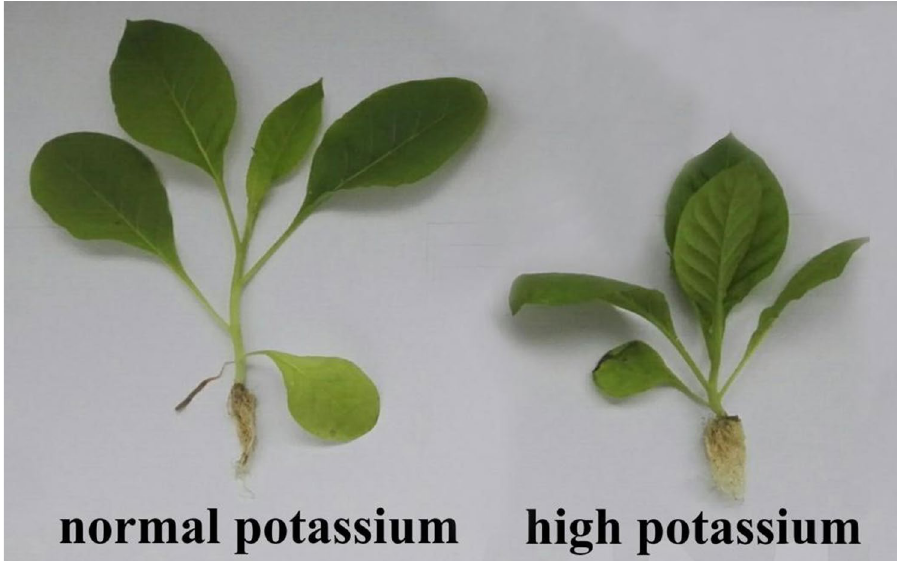
Figure 1. Phenotypic differences of tobacco seedlings grown at two potassium